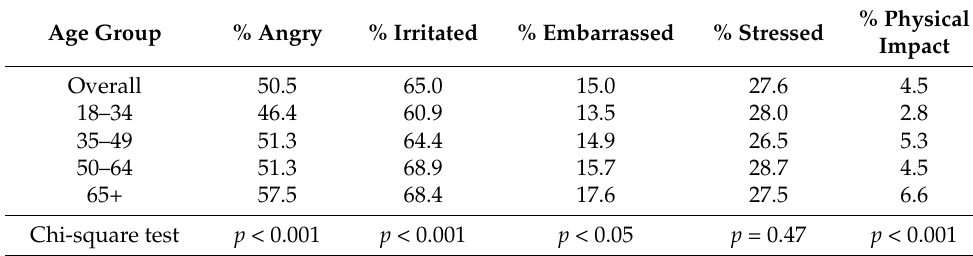
Table 7. Percentage of non-financial impact from online fraud in weighted sample. Age Group %